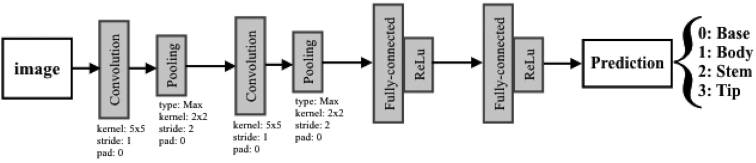
LeNet architecture.